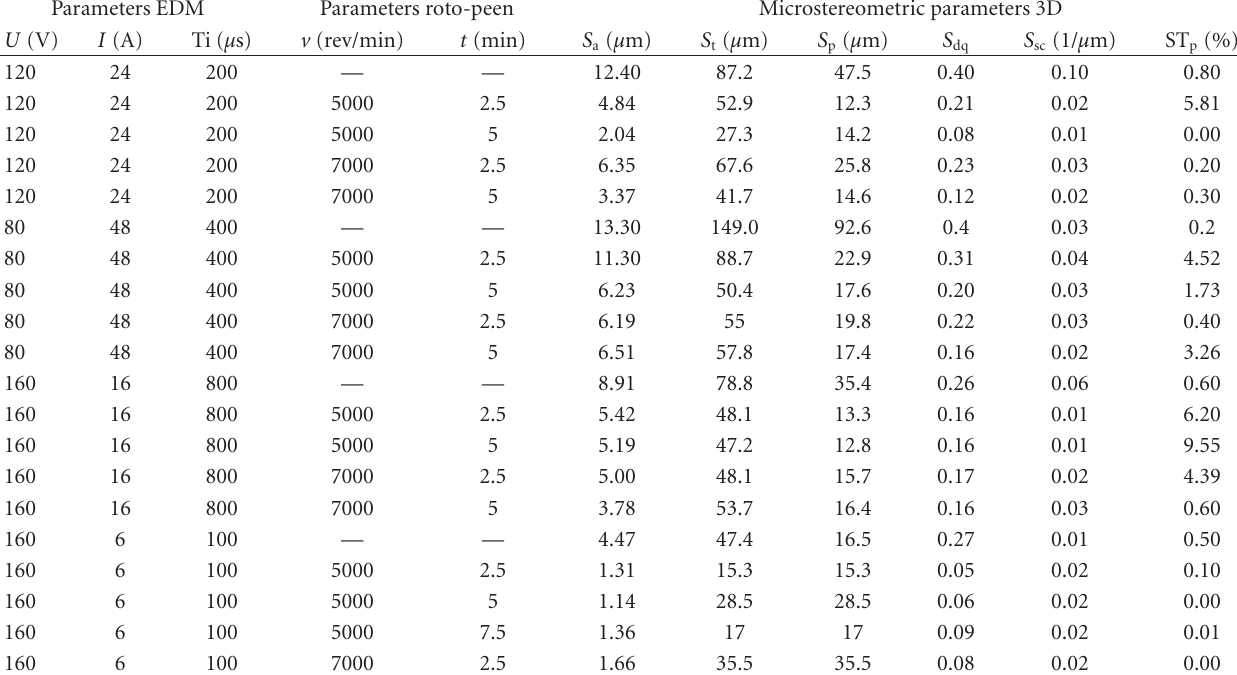
Table 1: Specification of surface microstereometry (3D) after the EDM and then the roto-peen machining. Parameters